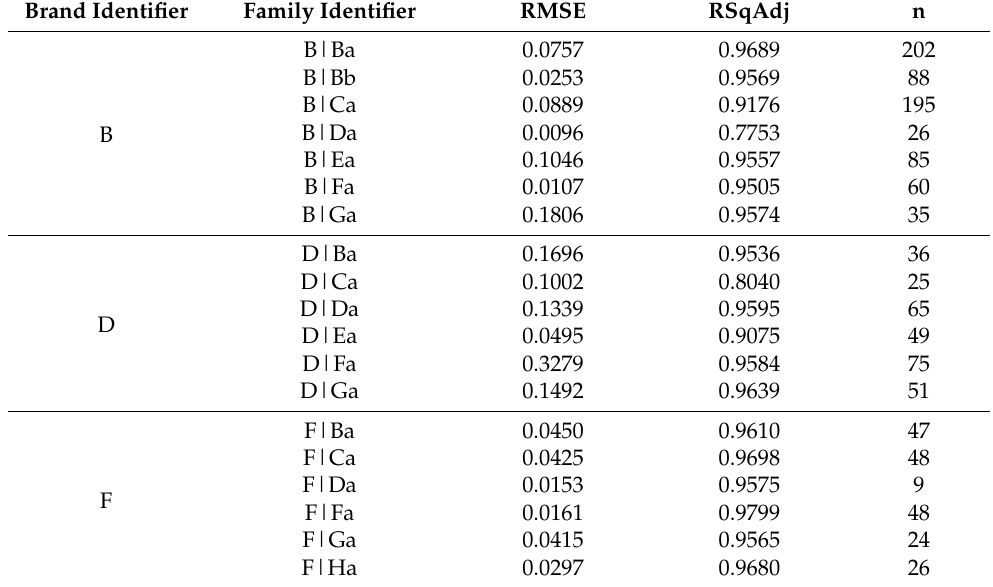
Table 4. Combine power regression results.